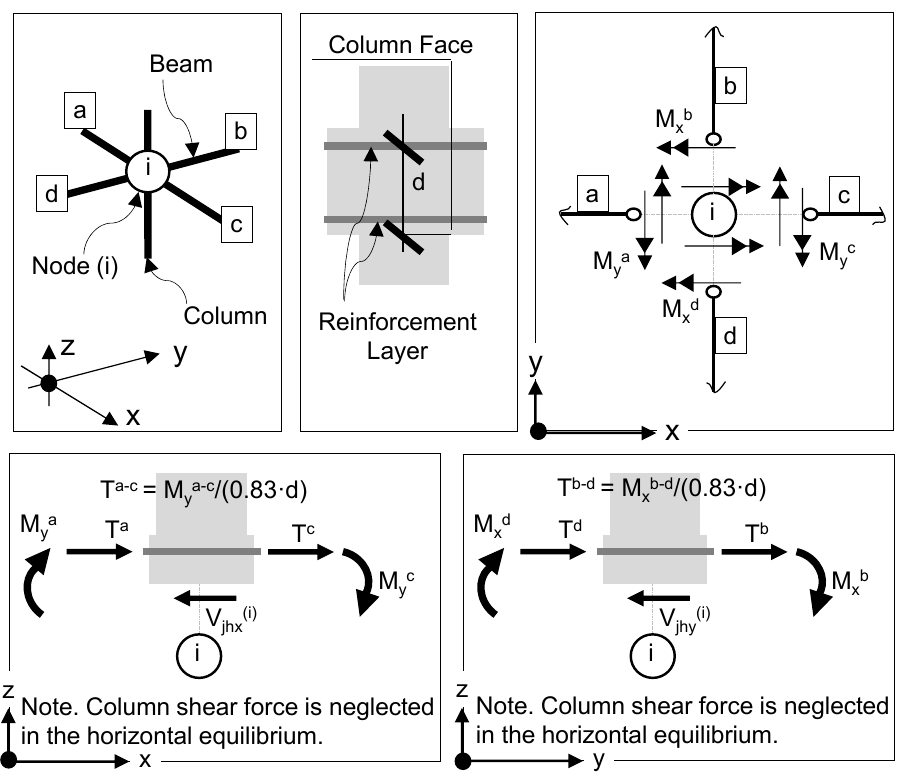
Figure 15. Post-process procedure to evaluate shear demand at beam–column joint “i”. (Note “a”, “b”, “c”, “d” labels define the converging beams at the